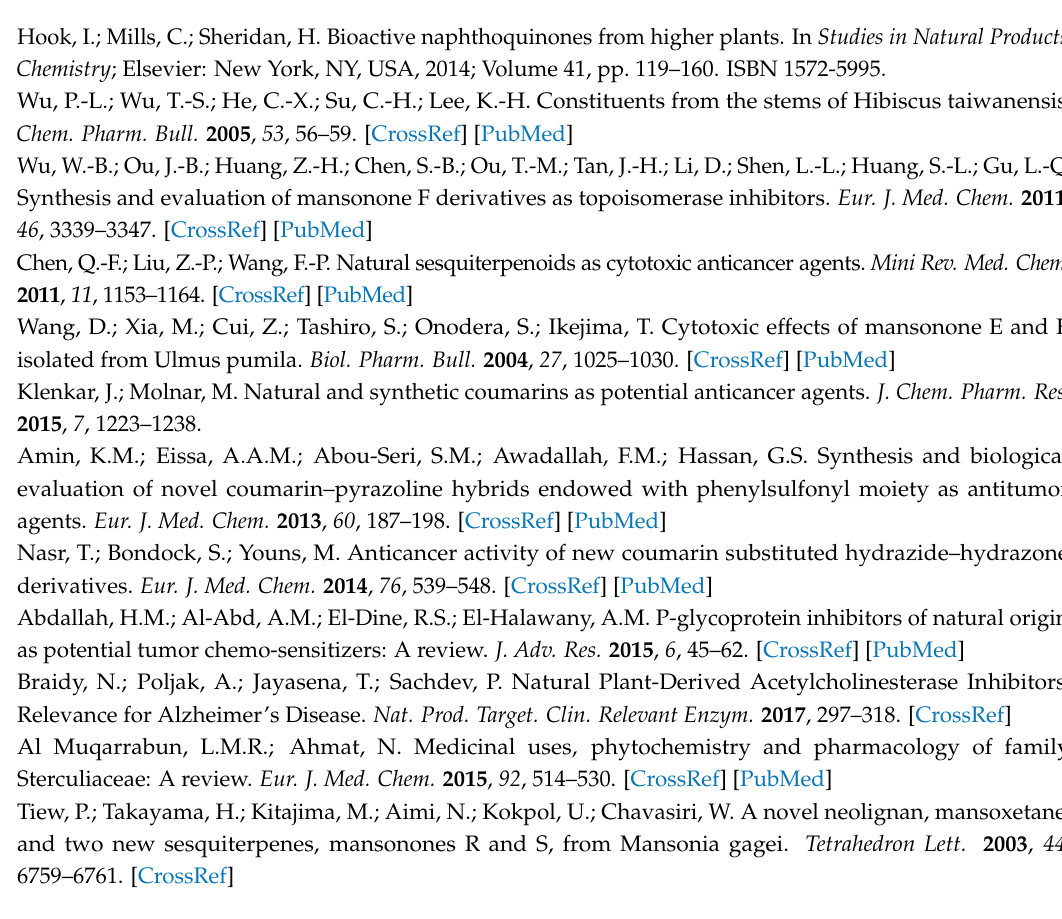
compound 2 , Figure S7. 1 H and 13 C NMR charts of compound 3 , Figure S8. 1 H- and 13 C-NMR charts of compound 4 , Figure S9. 1 H- and 13 C-NMR charts of compound 5 , Figure S10. 1 H and 13 C-NMR charts of compound 6 , Figure S11. 1 H- and 13 C-NMR charts of compound 7 , Figure S12. 1 H- and 13 C-NMR charts of compound 8